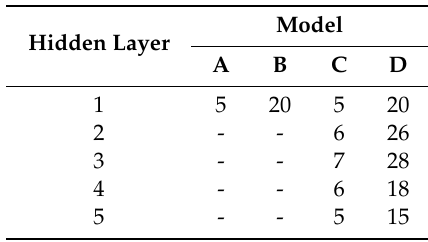
Table 7. Configuration of ANN